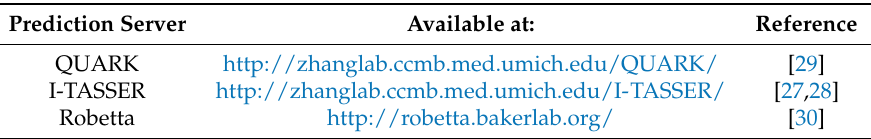
Table 2. The prediction servers